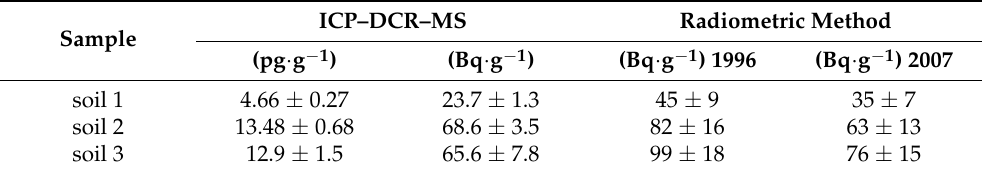
Table 7. Determination of 90 Sr activity in soil samples by ICP–DRC–MS and radiometric method [81,82].